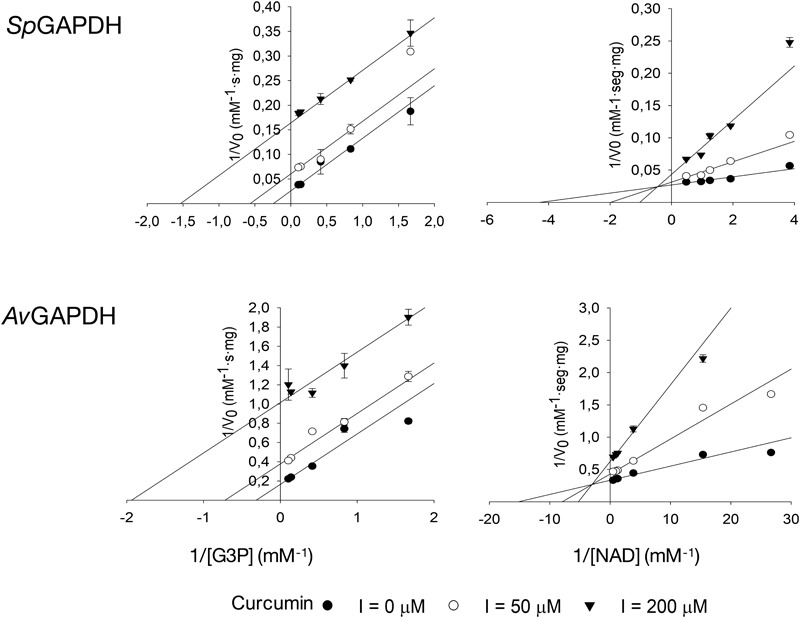
Inhibition of SpGAPDH and AvGAPDH by curcumin. Effect of increasing concentrations of curcumin on the kinetic parameters of SpGAPDH and AvGAPDH for G3P and NAD+ (CpGAPDH was not affected). Double-reciprocal representation of the inhibition kinetics, which is diagnostic of the uncompetitive model of inhibition.